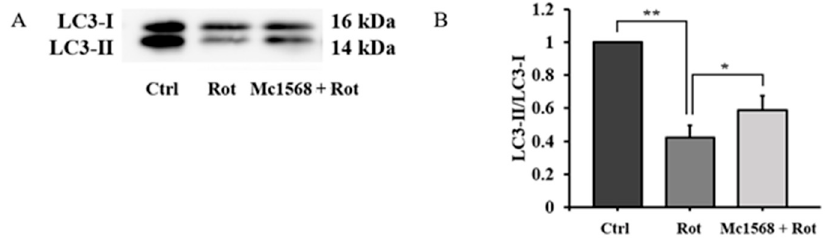
Figure 3. Mc1568 activated autophagy in SH-SY5Y cells. Levels of LC3 were detected through Western blot analysis. ( A , B ) Rotenone reduced the LC3- Ⅱ / LC3- Ⅰ ratio in SH-SY5Y cells, while mc1568 induced an increase in the LC3- Ⅱ / LC3- Ⅰ ratio. * p < 0.05; ** p < 0.01. Ctrl., control. Rot., rotenone.